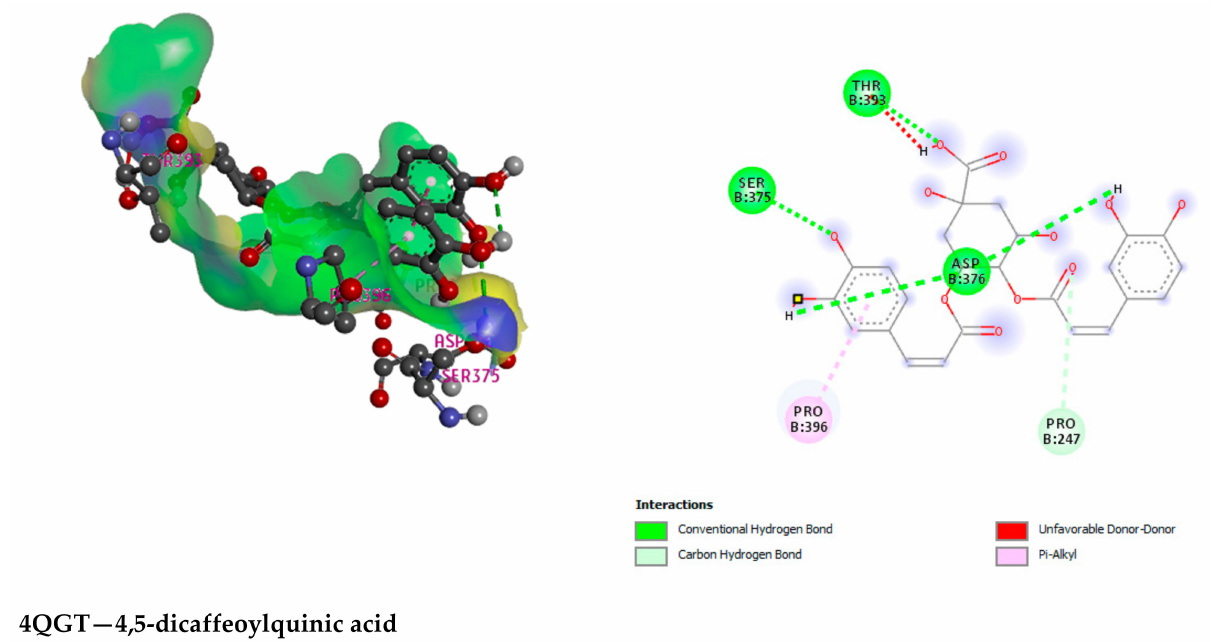
Figure 5. Illustration (2D and 3D) of the docking results of the best-ranked pose of key interactions in the binding pocket of Urate oxidase (Uox) (PDB ID: 1R4U) with Chlorogenic acid, Glutathione reduc- tase (PDB ID: 3GRS) with 4,5-dicaffeoylquinic acid, Hepatitis C Virus NS3/4A Protease (PDB ID: 3SU4) with 4,5-dicaffeoylquinic acid, Human IgG Fc Domain (PDB ID: 4QGT) with 4,5-dicaffeoylquinic acid, respectively. Table 7. Docking scores of 3-P-Coumaroylquinic acid, 4,5-Dicaffeoylquinic acid, Boscialin,